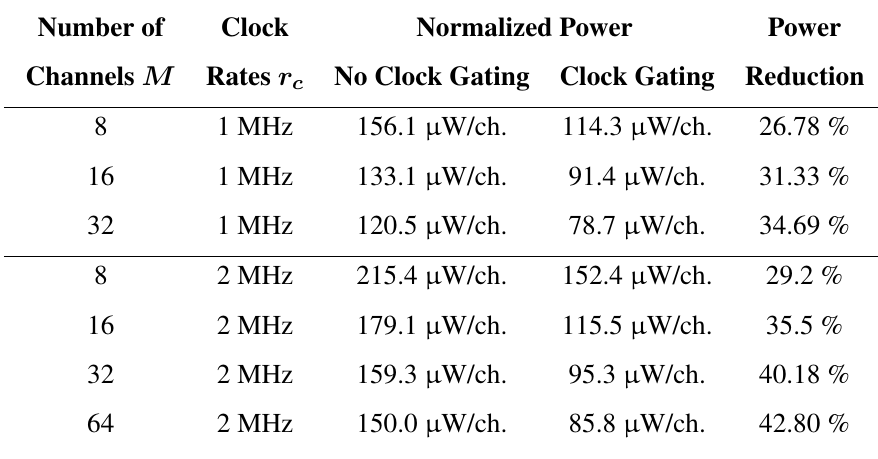
Table 8. The performance of the proposed spike sorting circuit for L = 8